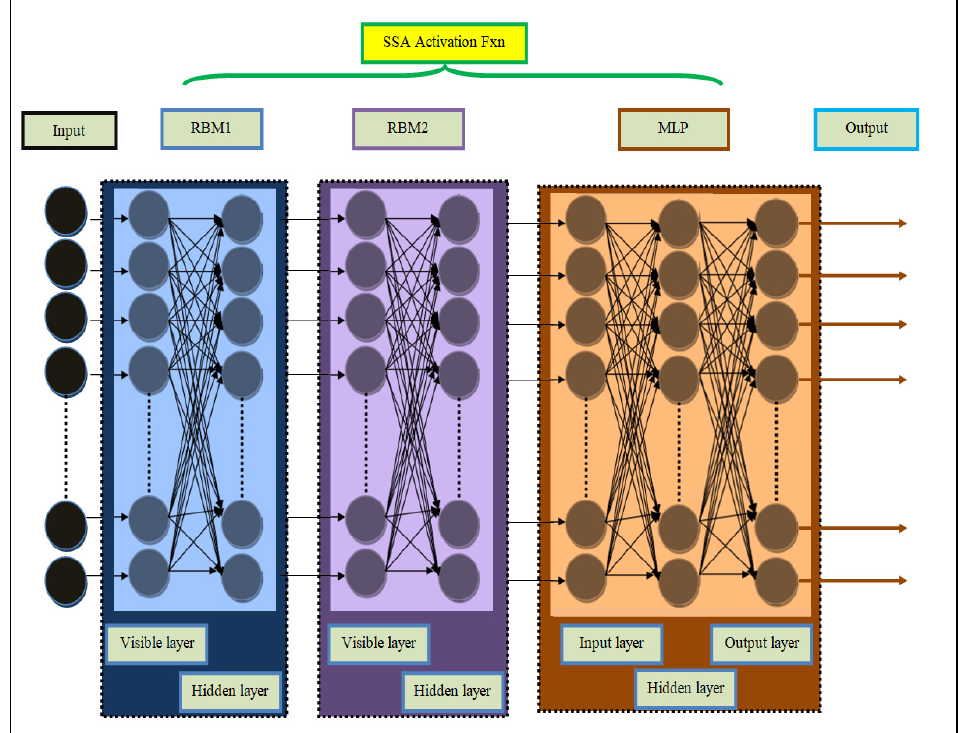
Figure 4. Proposed SSA_DBN architecture.